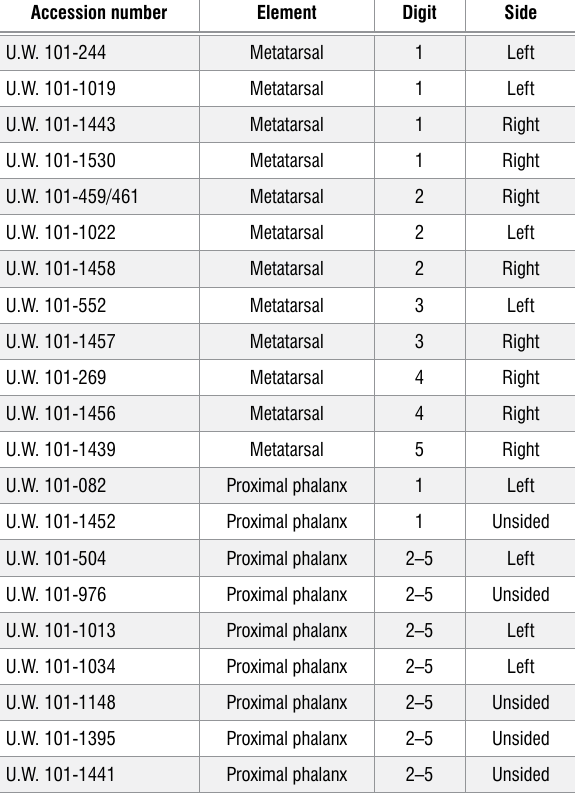
Table 1: Homo naledi fossil elements that were included in the pedal sample. Additional information and lengths described in the Supplementary Information of Harcourt-Smith et al.